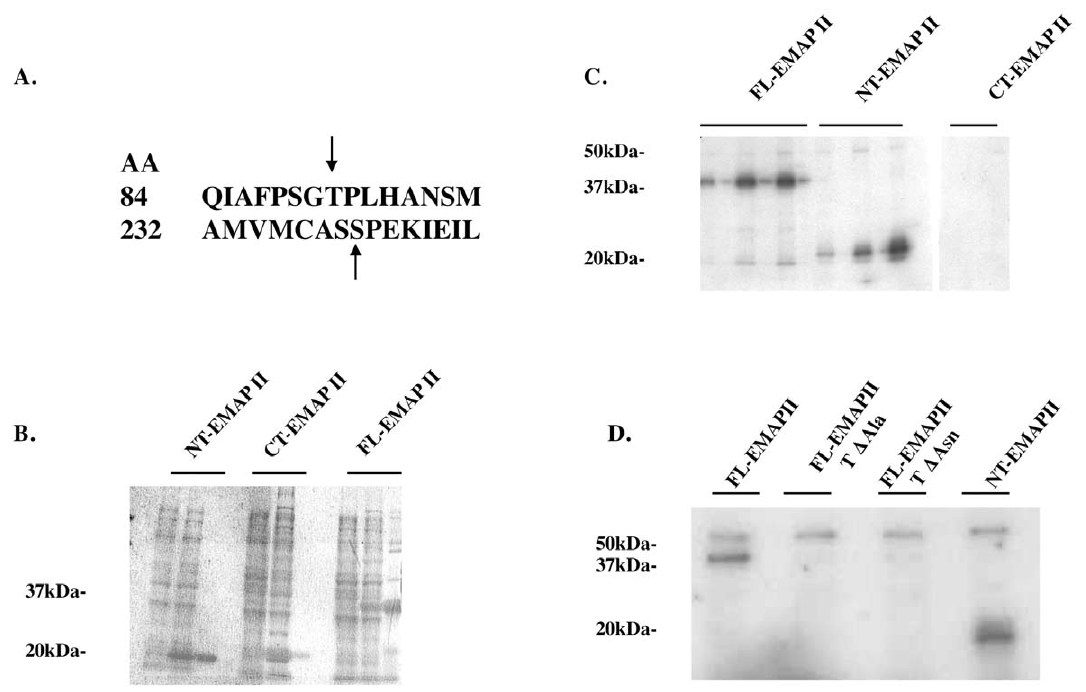
Figure 6. Cdk1 phosphorylates EMAP II at amino acid 84, threonine. Two potential Cdk1 phosphorylation sites were identified, aa 84 threonine, and serine at aa 232 (A). Using recombinant EMAP II protein isolates (B) in a Cdk1 assay, only the N-terminal and full-length EMAP II were phosphorylated by Cdk1 (C). Point mutation within the threonine (aa 84) to change the amino acid to either asparagine or alanine eliminated Cdk1 phosphorylation, thus confirming that the 84 aa threonine was the site of Cdk1 phosphorylation of EMAP II (D) (these experiments were performed 3 times).